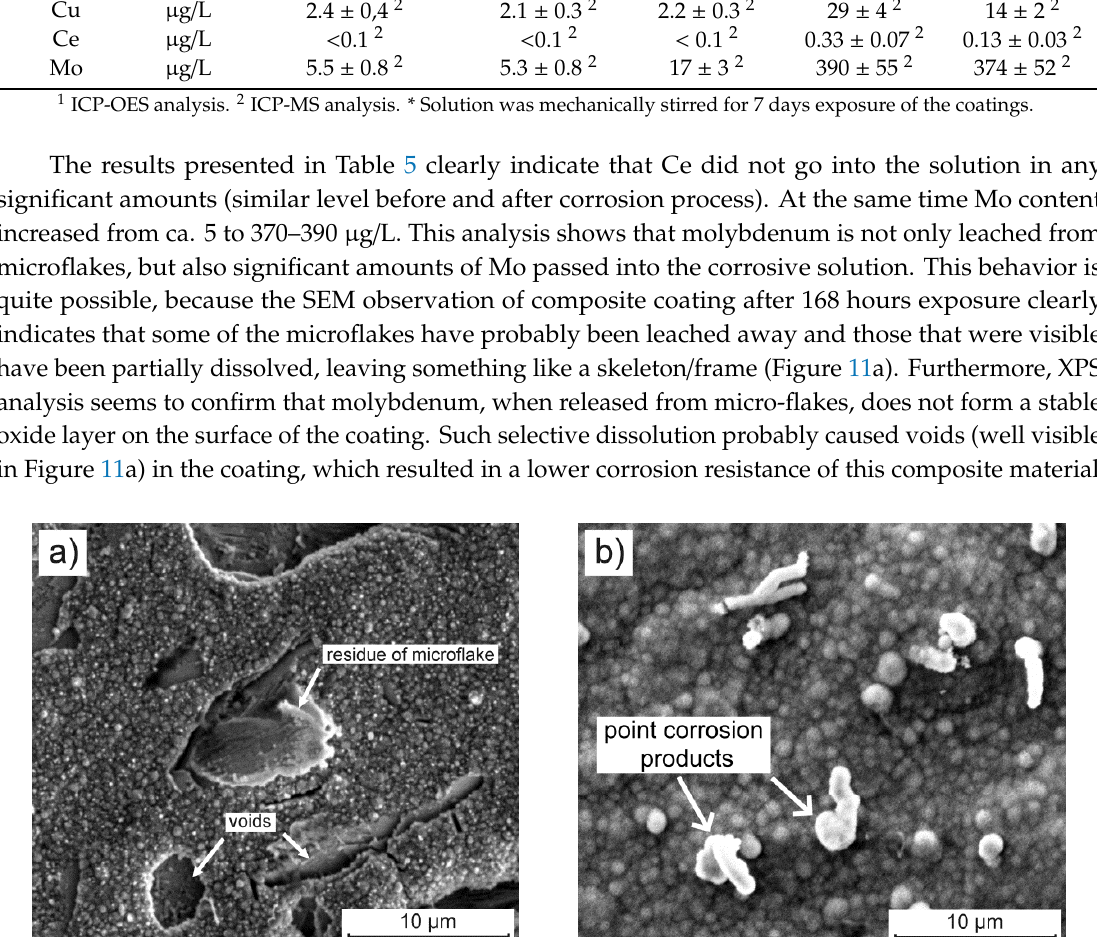
Table 5. Concentrations of Ni, Cu, Ce, and Mo in a corrosive solution.